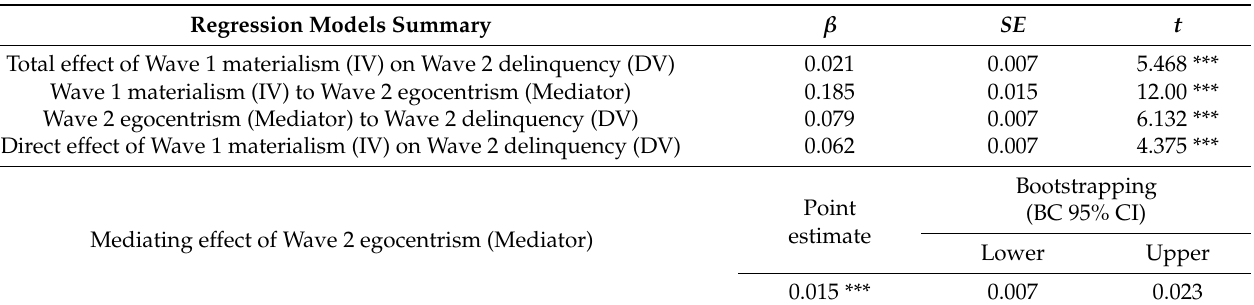
Table 7. Mediating effect of Wave 2 egocentrism (the mediator) for the effect of Wave 1 materialism on Wave 2 delinquency with Wave 1 delinquency